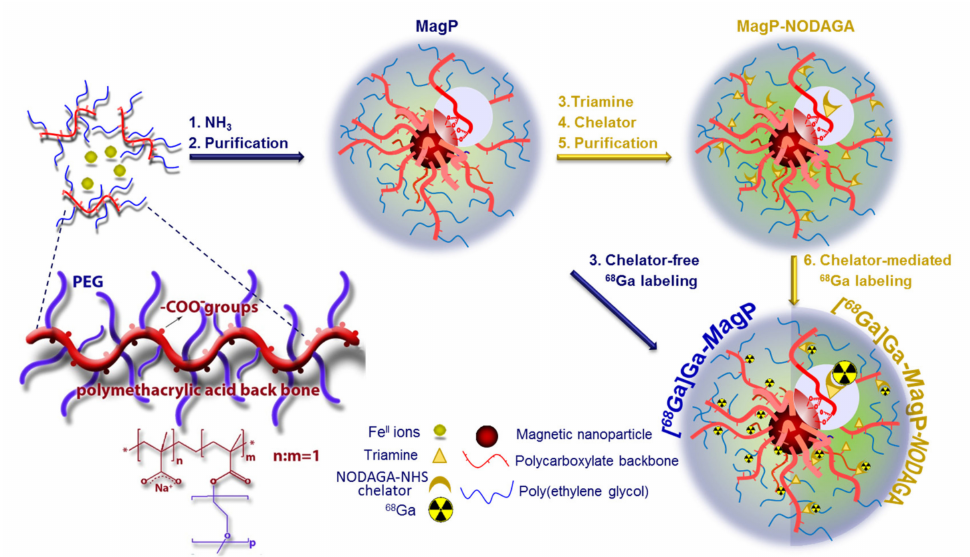
Figure 1. The steps followed for the synthesis of MagP MIONs and the radiolabeled derivatives through chelator- free or chelator-mediated radiolabeling. The structure of the PEG-branched copolymer of poly(methacrylic acid)-graft- poly(ethyleneglycol methacrylate) is also